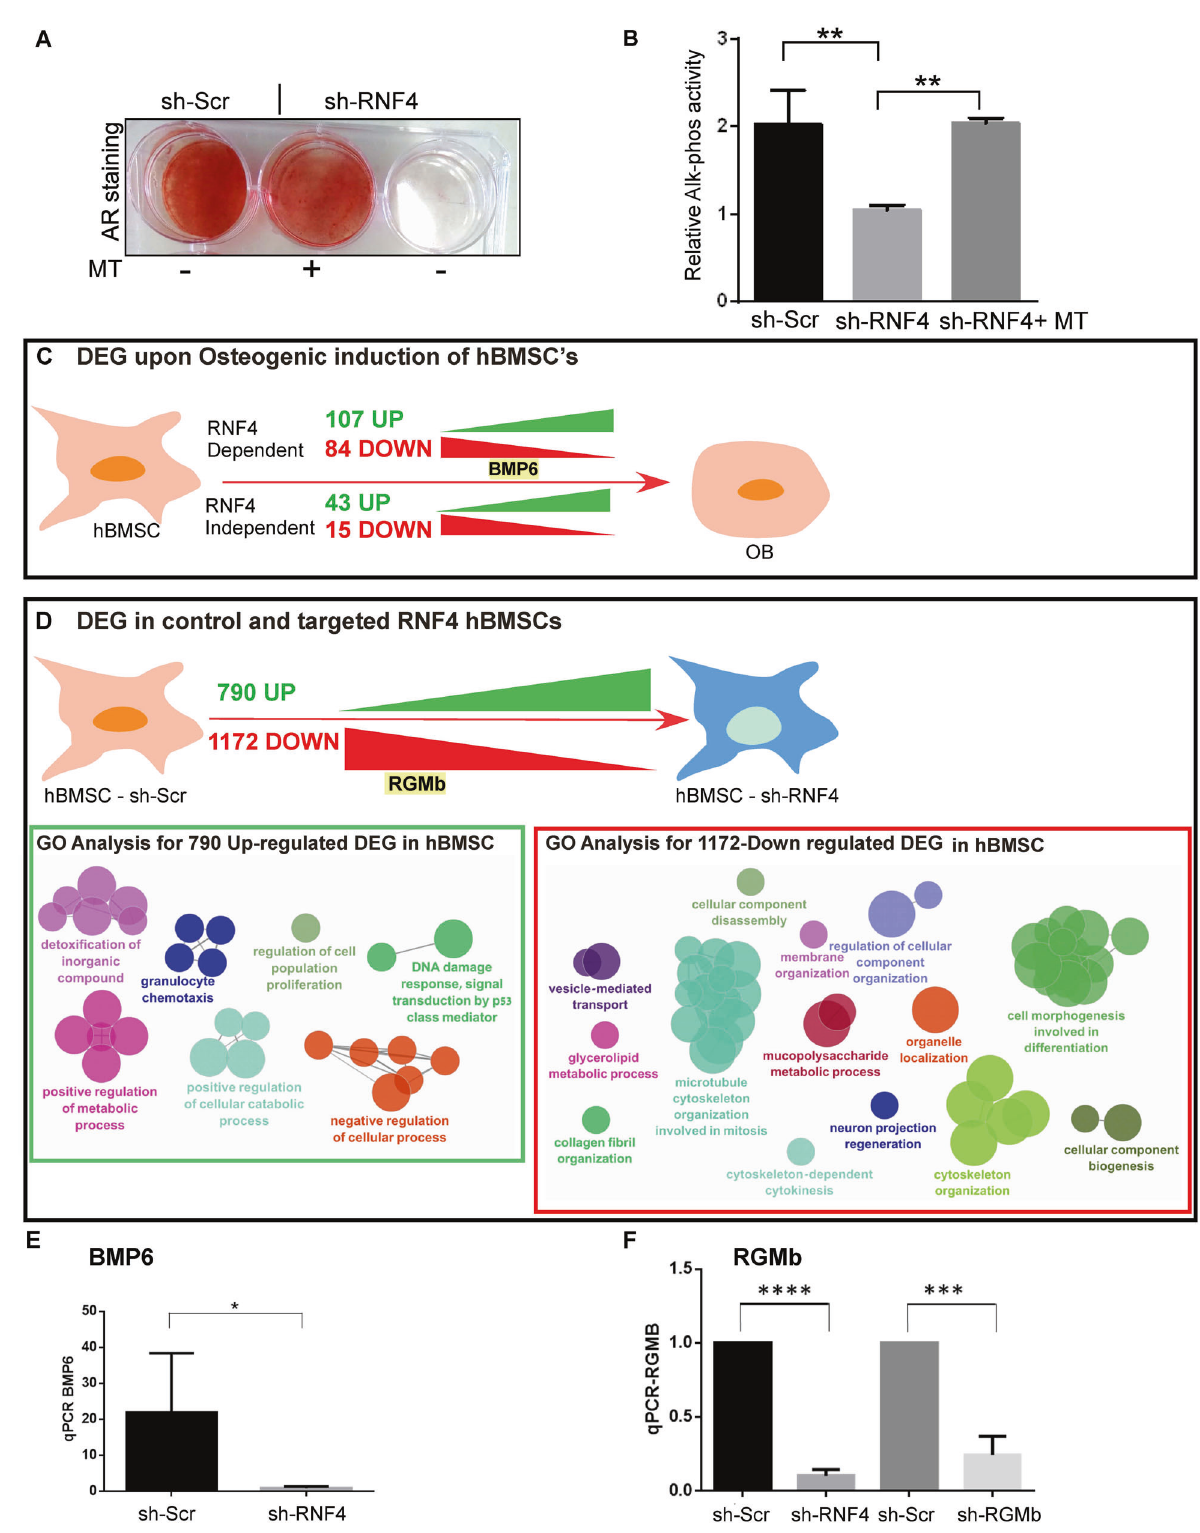
RNF4-dependent OD requires BMP6 together with its co- receptor RGMb Since conditioned media from hBMSCs enabled differentiation of RNF4-de fi cient stalled hBMSCs, we searched our RNA-Seq datasets for factors (soluble or partially anchored to the extracellular cell membrane) whose expression requires RNF4 and that are relevant